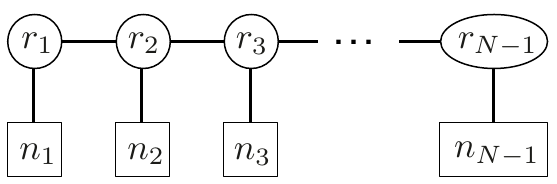
Figure 1 . The general 6d linear quiver